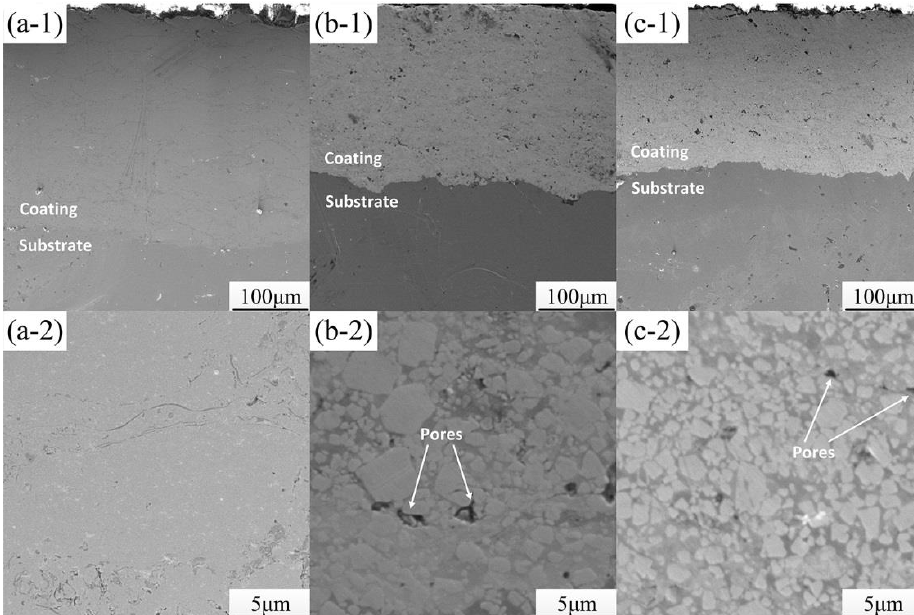
Figure 3. Cross-sectional microstructures of the coatings: Cobalt-based alloy at low-magnification ( a – 1 ) and high-magnification ( a – 2 ); WC-12Co at low-magnification ( b – 1 ) and high-magnification ( b – 2 ); WC-17Co at low-magnification ( c – 1 ) and high-magnification ( c – 2 ).